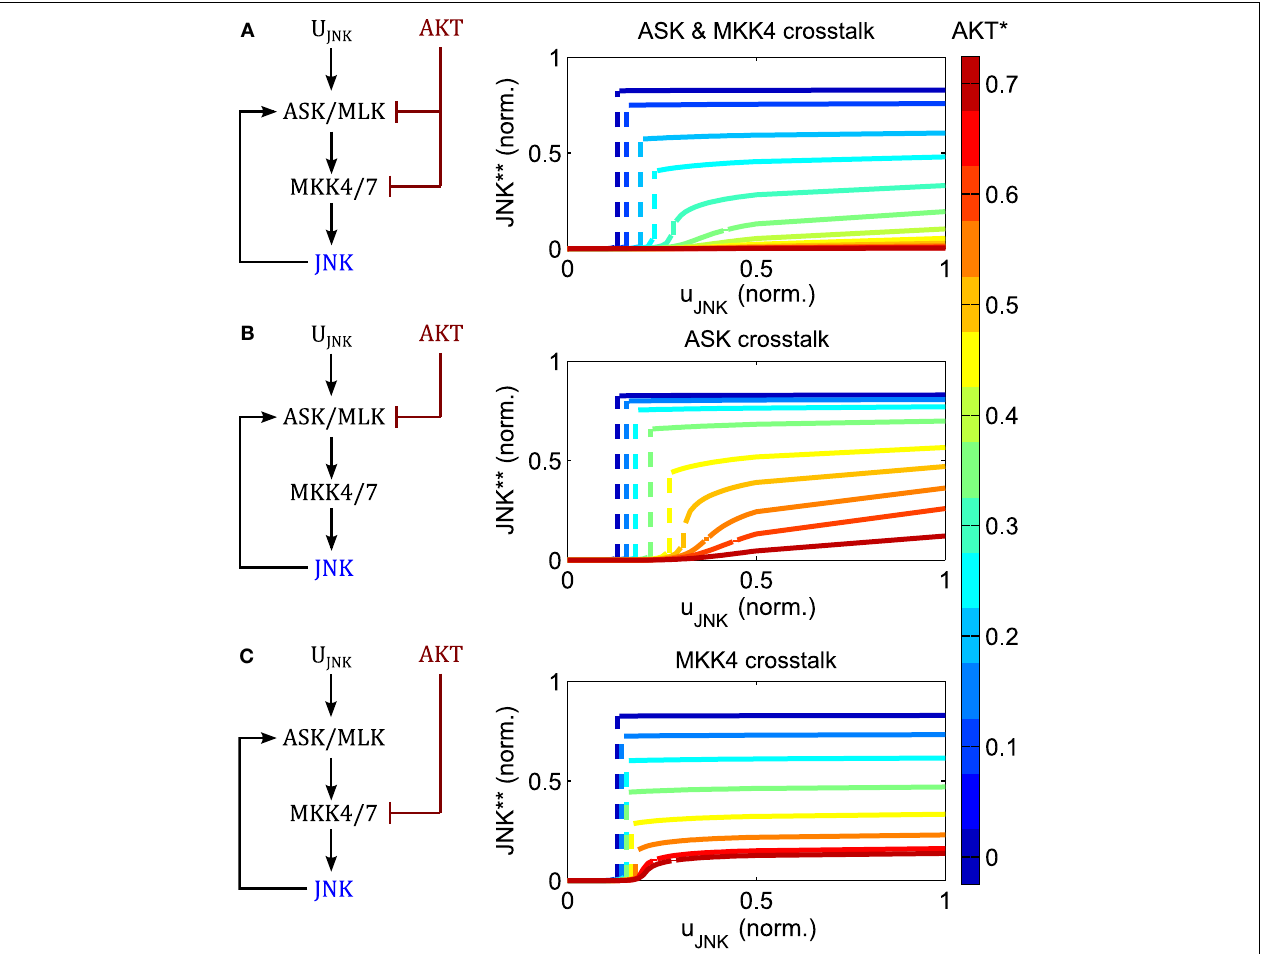
indicated. Left: interaction scheme. Right: dose responses with respect to the JNK input u JNK for different AKT activation levels; u JNK ( t ) = ˆ u JNK for t > 0; u AKT = ˆ u AKT for all t ; blue curves indicate low, red lines high AKT activity; dashed lines indicate a switch from low to high JNK